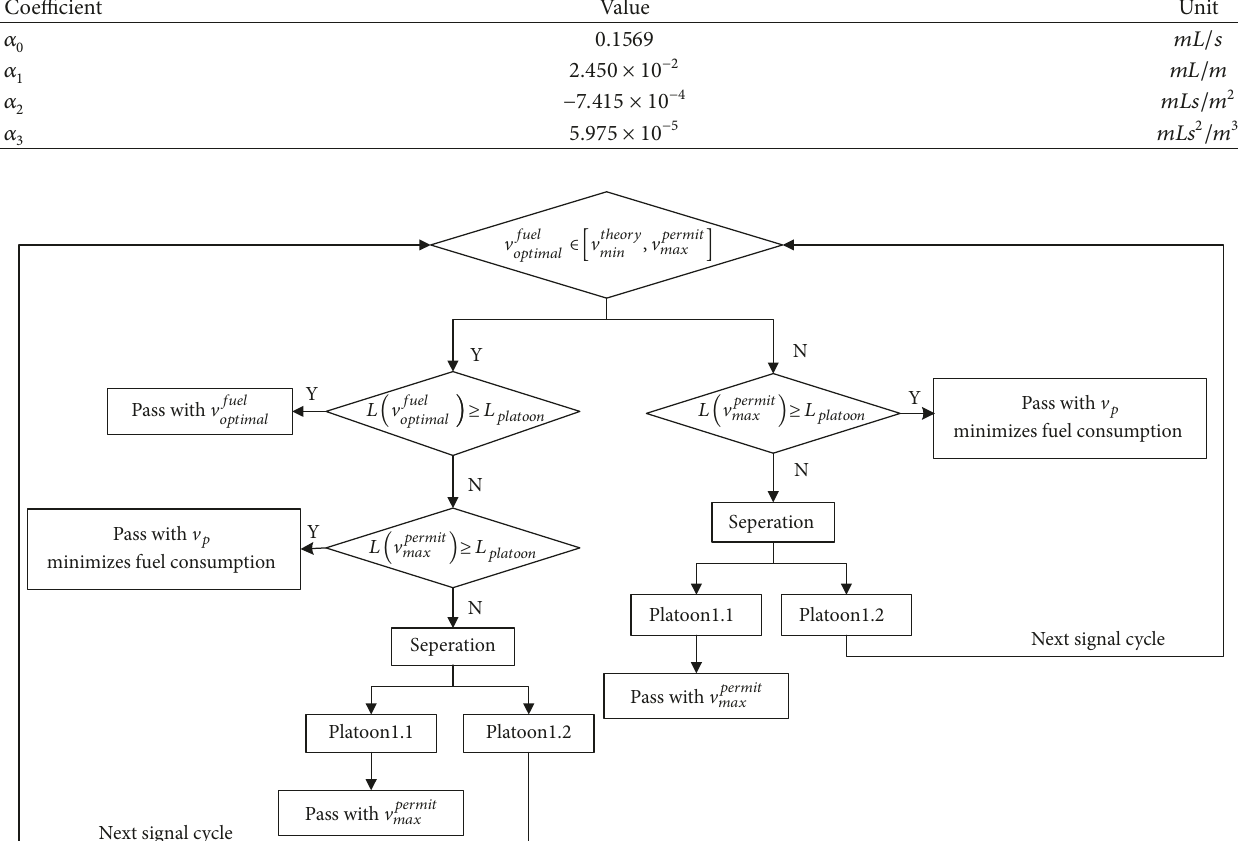
Figure 6: The process of our proposed velocity control and separation